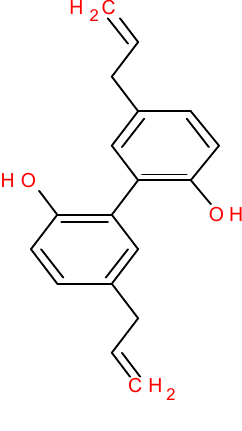
Figure 1. Structure of magnolol.